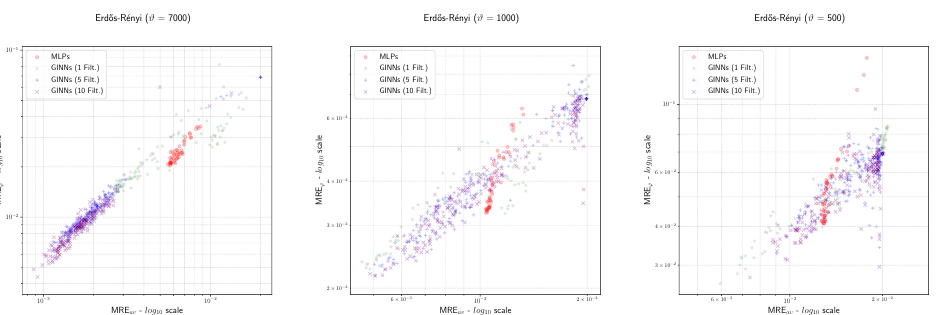
Figure 7. Network . Scatter plots in the ( MRE av ,MRE ϕ ) plane. Left to right: NNs trained with G 2 ϑ = 7000,1000,500 samples. Red circles: MLPs; green stars, blue crosses and purple “x”: GINNs with F = 1,5,10,